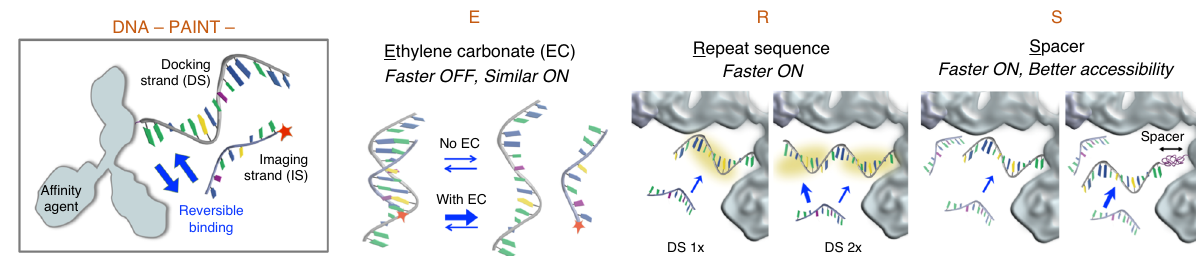
Fig. 1 Schematics of DNA-PAINT-ERS. First panel illustrates the standard DNA-PAINT process. Second to fourth panels depict the effect of ethylene carbonate (E), repeating sequence (R), and spacer (S), respectively. In the latter two cases, the DNA oligos and the antibody are drawn roughly to